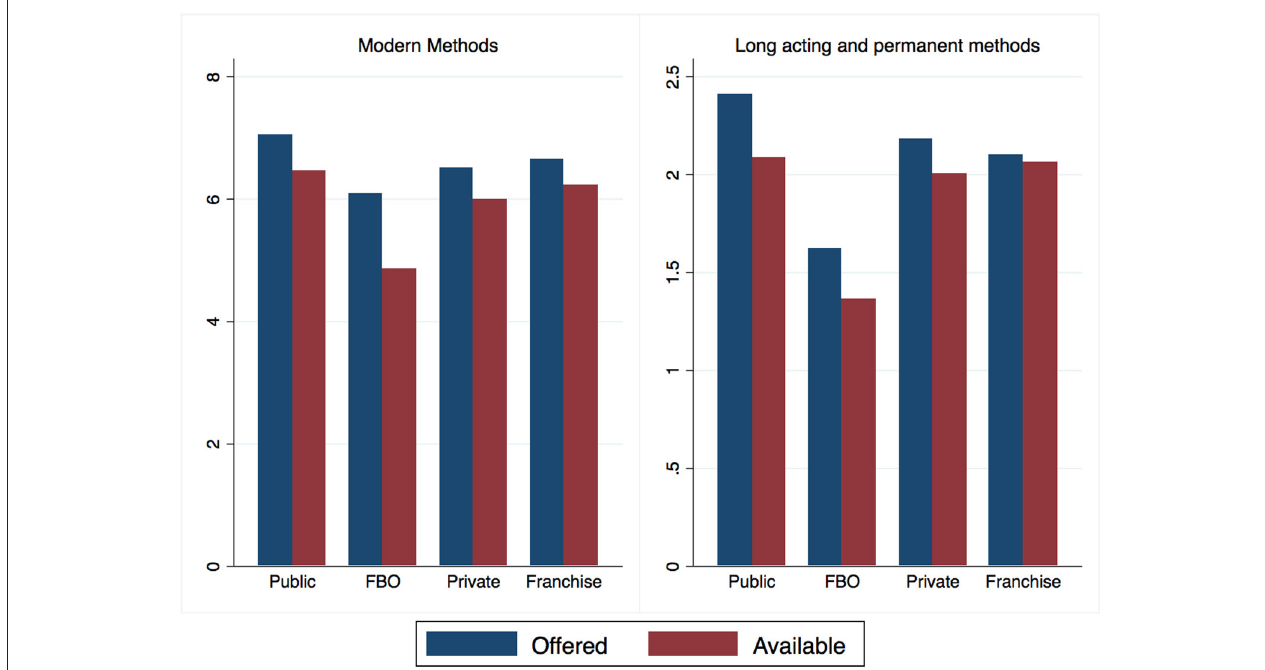
FIGURE 1 | Mean number of FP methods offered and available by facility type.